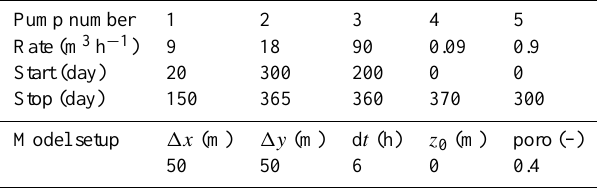
Table 1. Pumping rates and general model setup ∗